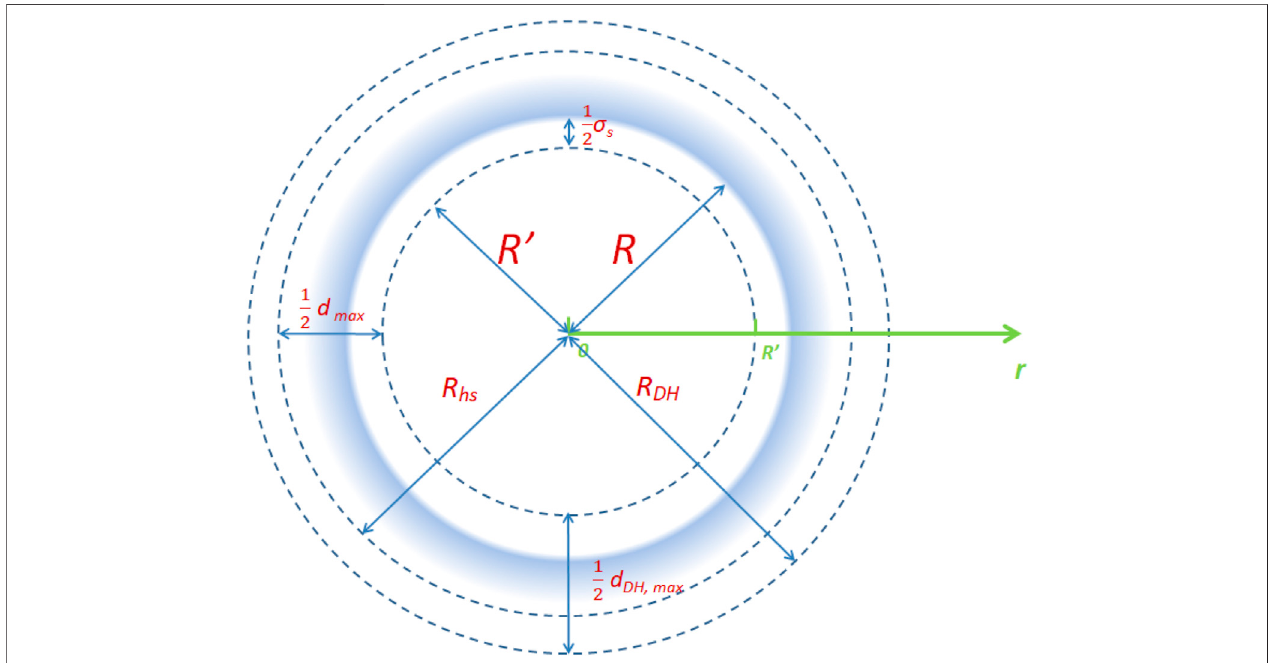
FIGURE 1 | Schematic diagram of the domains considered in a spherical